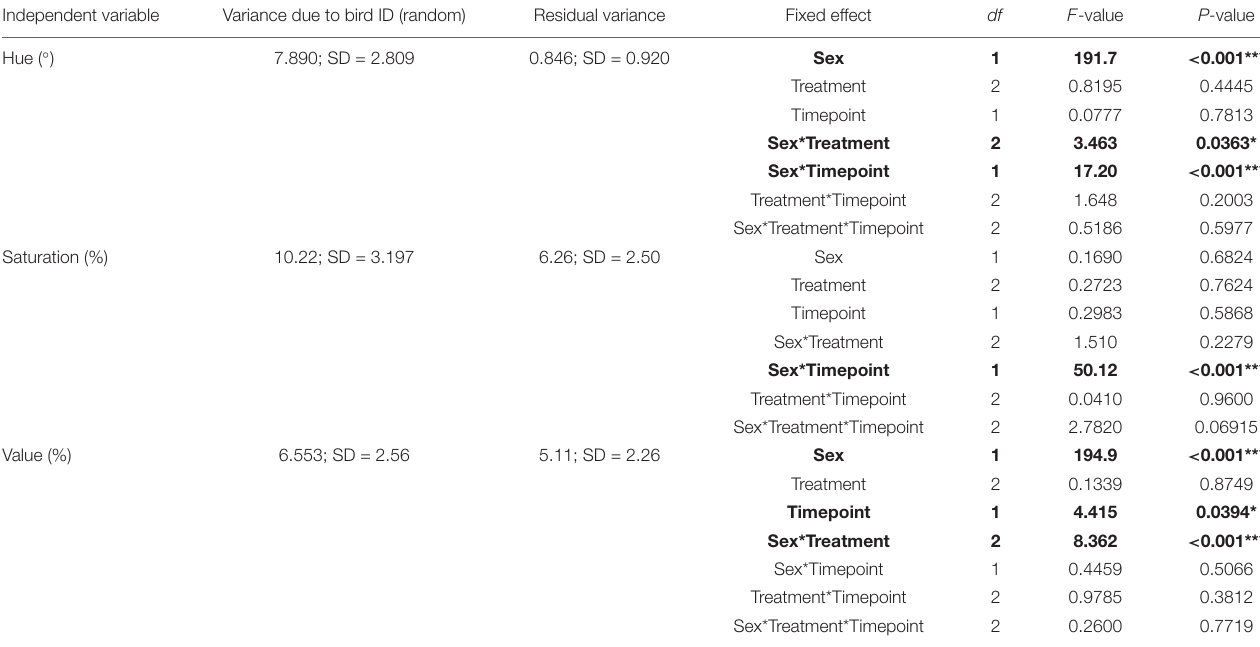
TABLE 2 | Statistical summary of the short-term changes in beak color due to repeated handling and incubation temperature (Aim 2) using a global linear mixed effects model. Independent variable Variance due to bird ID (random)